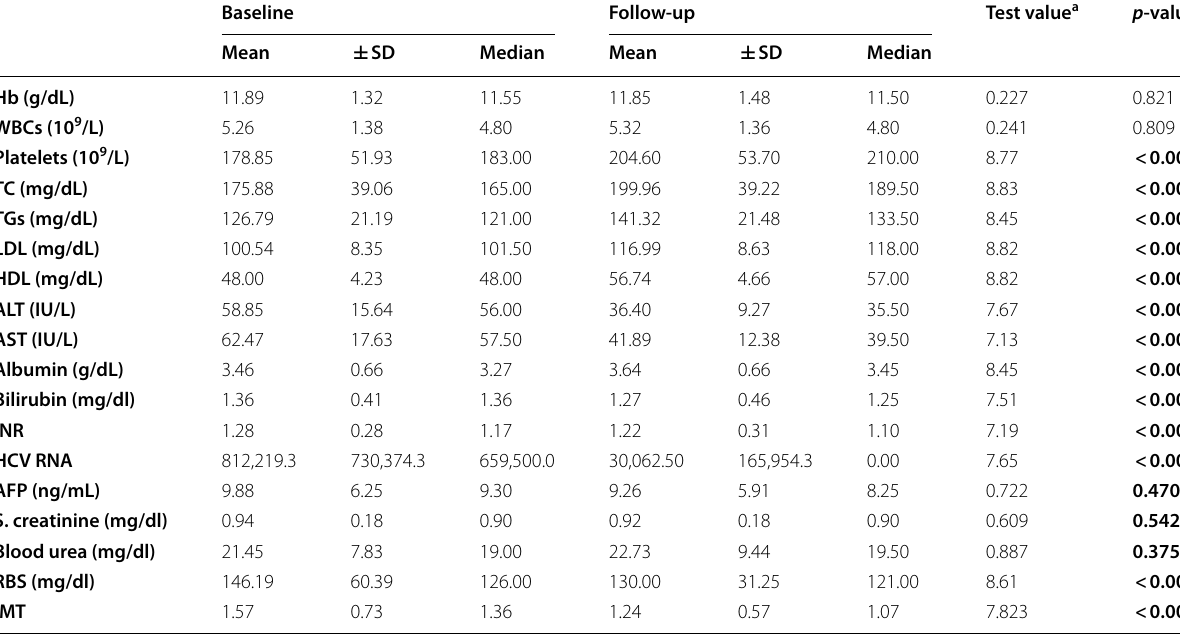
p 0.05 is considered statistically significant; p 0.01 is considered highly statistically significant. a Wilcoxon signed-rank test. SD Standard deviation, TC Total ≤ ≤ cholesterol, TGs Triglycerides, p 0.05 is considered statistically significant, p 0.01 is considered highly statistically significant, AFP Alpha-fetoprotein, RBS Random ≤ ≤ blood sugar, IMT Intima-media thickness. On comparing laboratory data before starting treatment and 6-month follow-up after treatment, it was noticed that platelets, total cholesterol, triglycerides, LDL, HDL, and albumin were significantly increased after treatment, while ALT, AST, bilirubin, INR, and RBS were significantly decreased after treatment. There was no statistically significant difference in Hb, WBCs, AFP, serum creatinine, and urea. Regarding HCV RNA, 96.25% became negative 6 months after treatment with DAAs. IMT was significantly decreased 6 months after treatment 1.24 vs. 1.57 mm p < 0.001